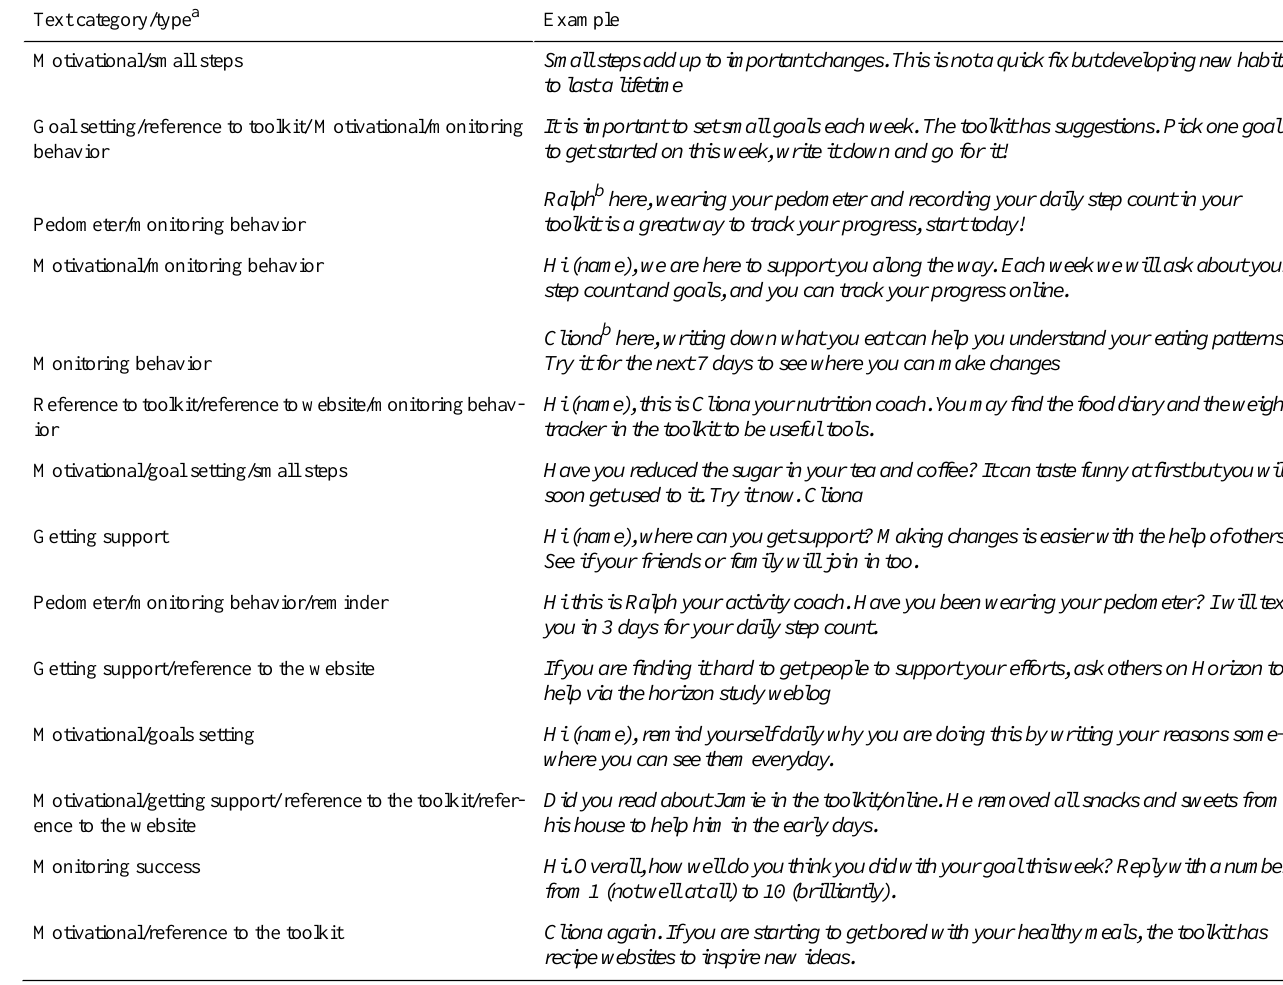
Table 4. Text messages in the Horizon prototype for the first